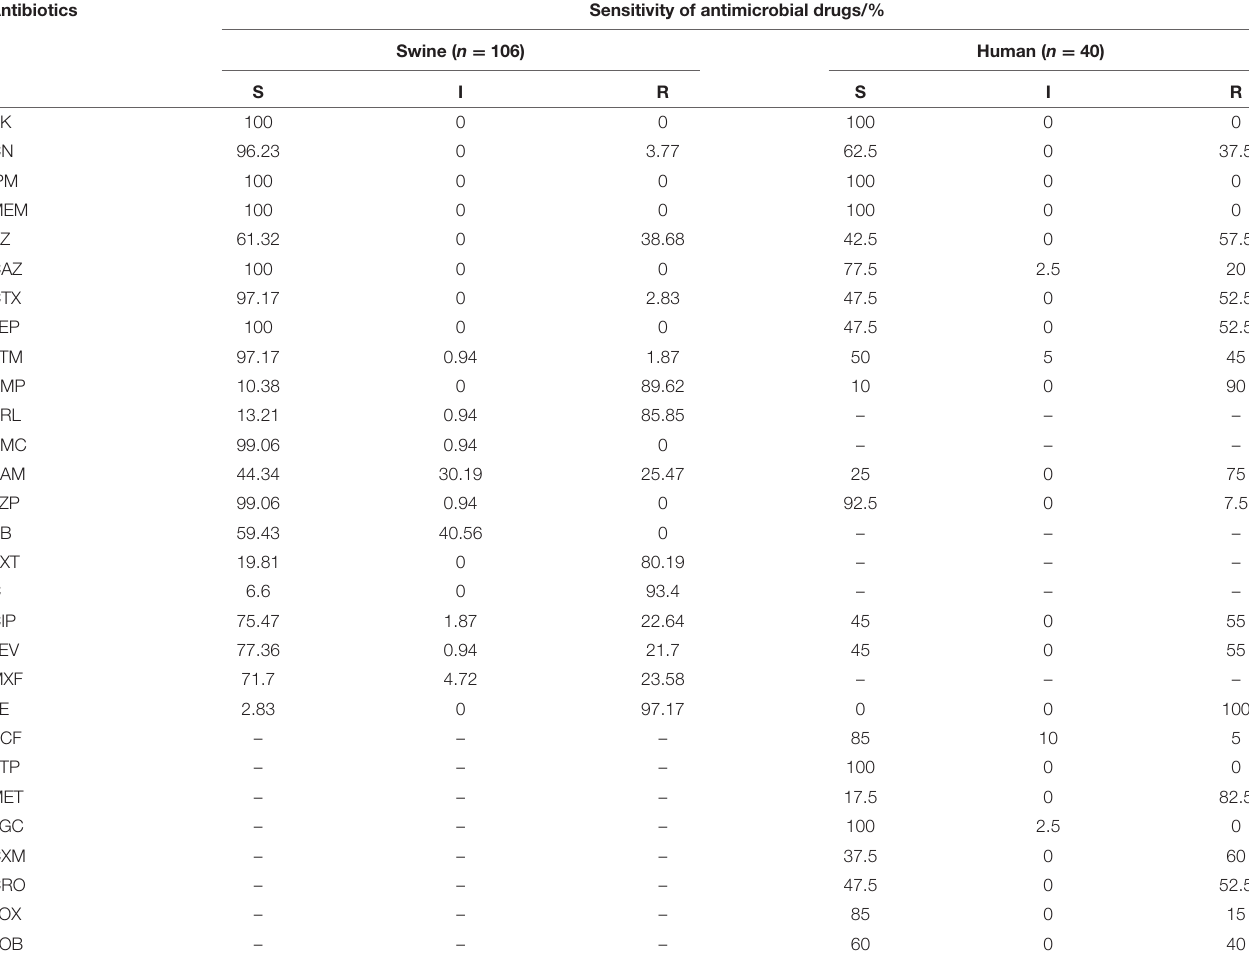
TABLE 3 | The results of antibiotic susceptibility rates of the two sources of E. coli.